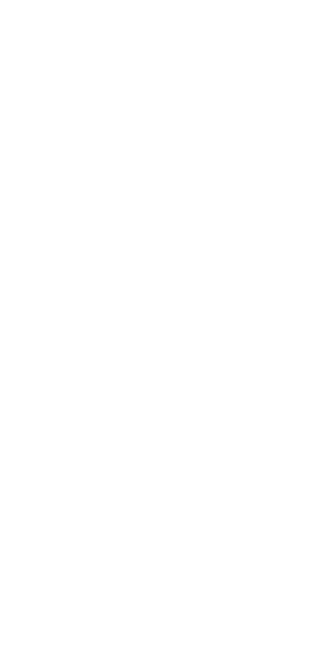
region of patient 2 (from Table 2 ) across week 0-6 and 1-month